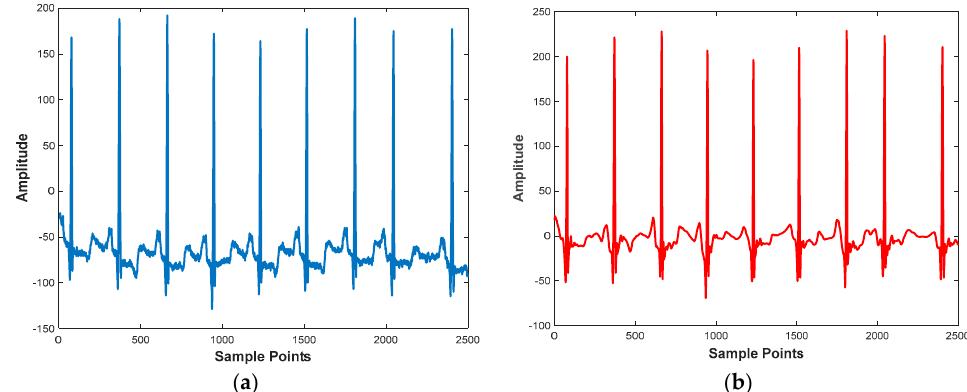
Figure 2. Comparison between the original signal and the denoised signal of Record-100 from MIT-BIH-AHA database. ( a ) the original signal; ( b ) the denoised signal.